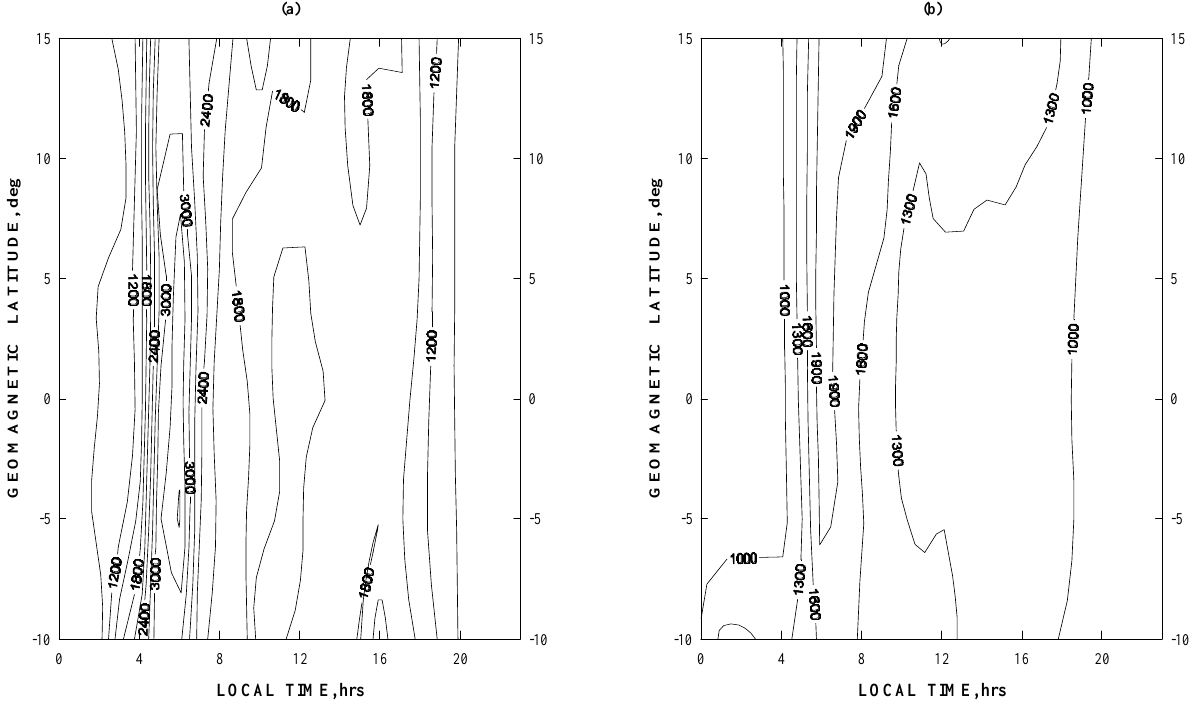
Fig. 6. Latitudinal and diurnal variations of electron temperature at ∼ 500km for (a) observed and (b) IRI in the equinoxes. Fig.6. Latitudinal and diurnal variation of electron temperature at ~500 km for (a) observed and (b) IRI in the equinoxes.